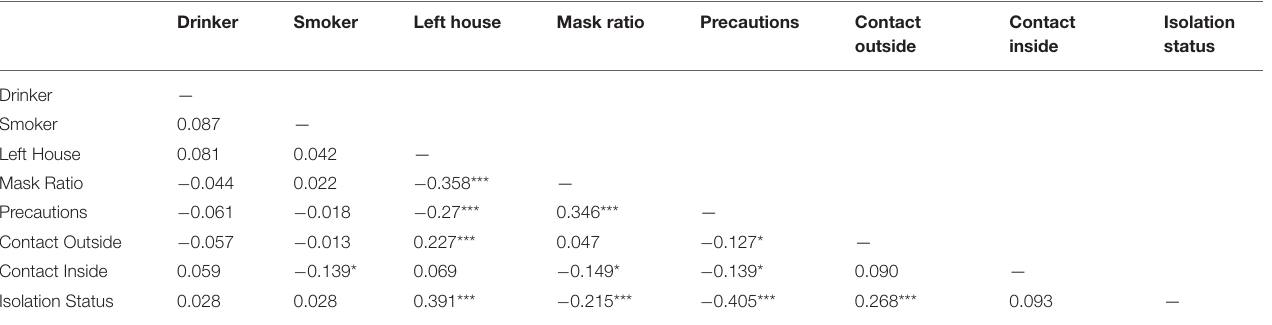
Drinker Smoker Left house Mask ratio Precautions Contact